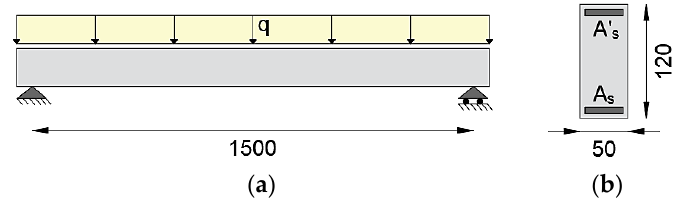
Figure 2. ( a ) Static scheme of the statically determinate beam; ( b ) cross-section geometry (dimen- sions in cm). in cm).